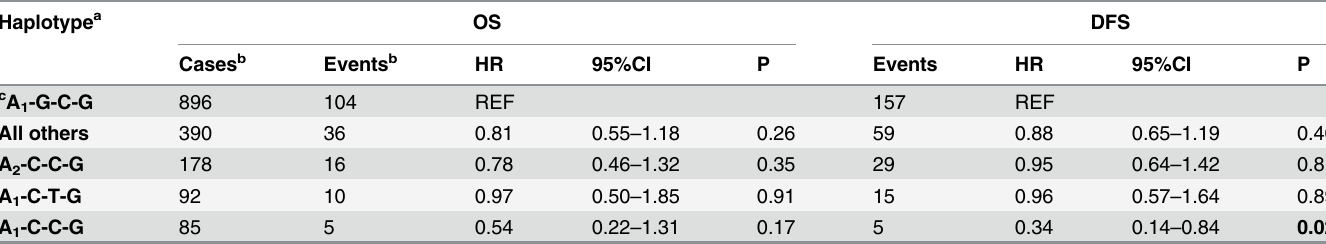
Table 4. OS and DFS in relation to haplotype distributions (Cox regression).